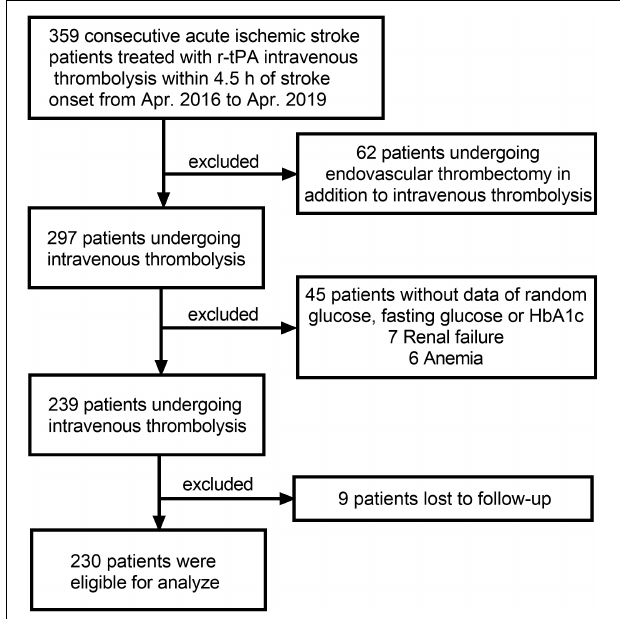
FIGURE 1 | Flow diagram showing the patient selection